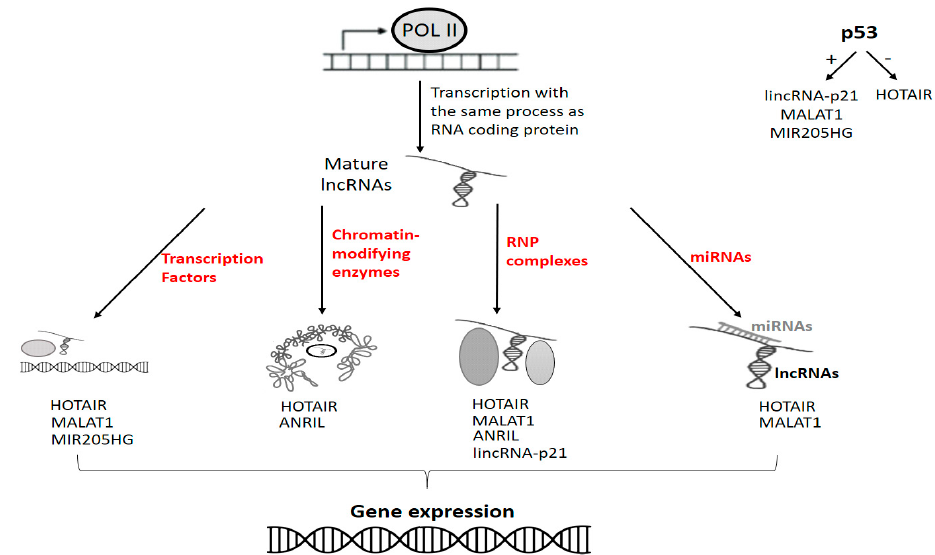
Figure 7. In red are indicated the main interactions accounting for lncRNAs gene expression regulation. Some oncogenic lncRNAs (upper right side of the figure) are positively or negatively regulated by p53.